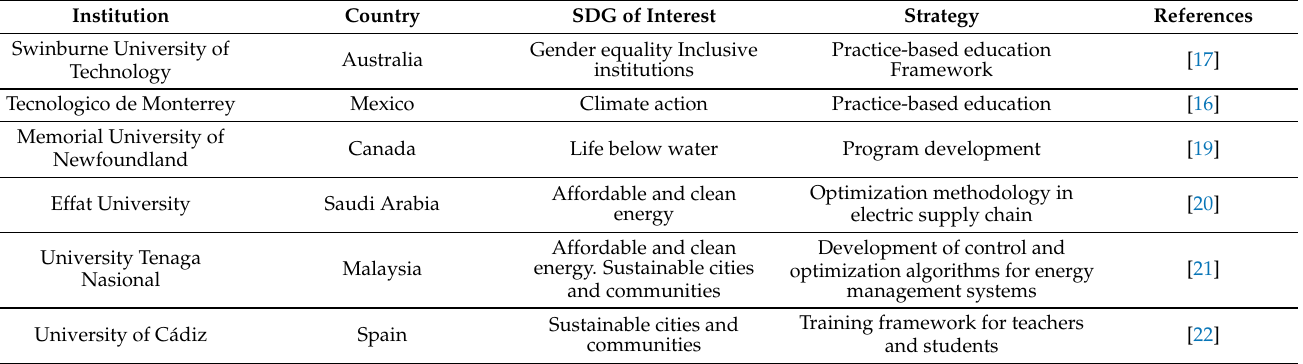
Table 1. SDG addressed by different